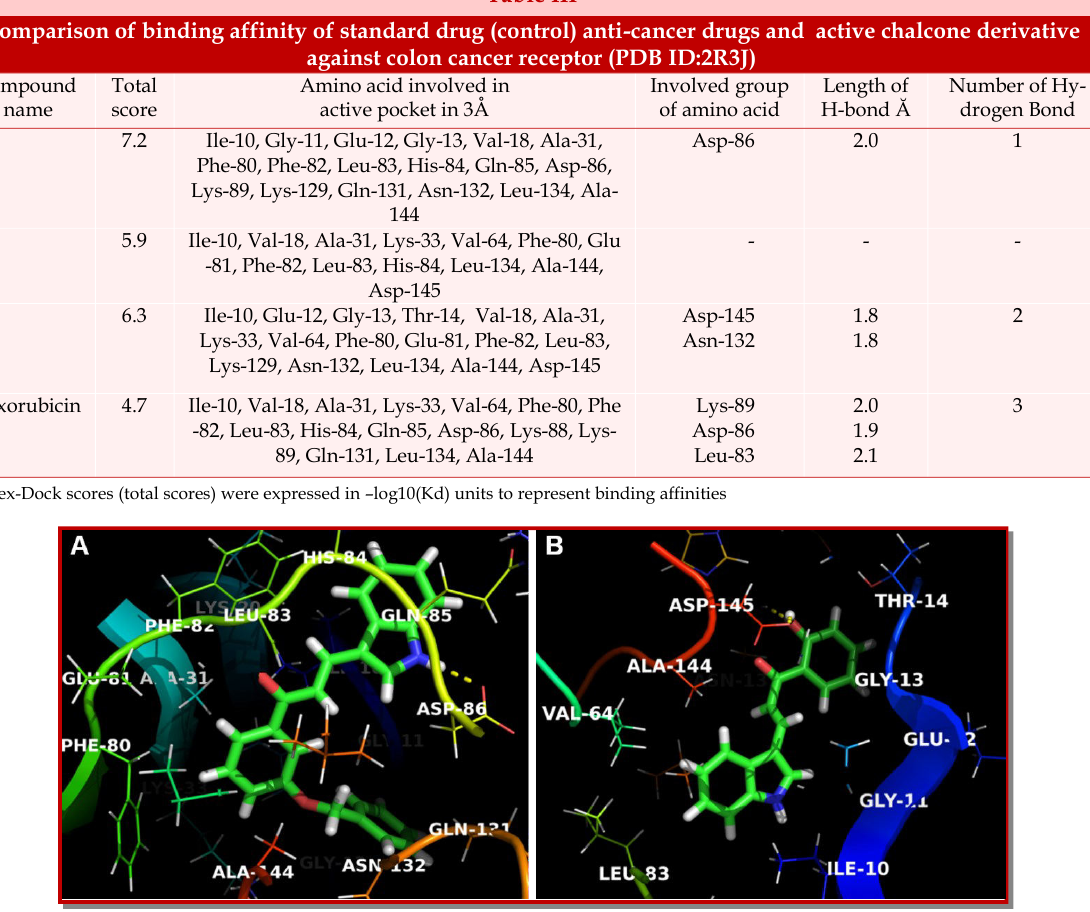
Figure 3: In silico molecular docking studies elucidating the possible mechanisms of compound 1b and 1g induced modulation of colon cancer protein (CDK2) receptor (PDB: 2R3J). The docking studies were carried out using SYBYL-X 2.0, Tripos International. Compound 1b and 1g docked on CDK2 form a H-bond of length 2.0 and 1.8Å to the binding pocket residue Asp-86, Asp-145 and Asn-132 and total score 7.1740 (A) and 6.3035 (B) was